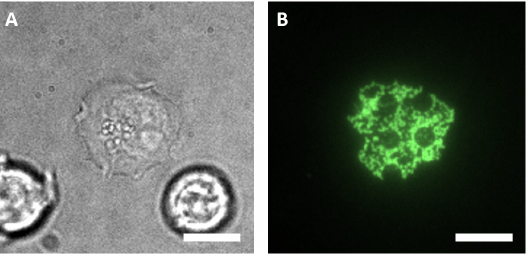
Figure4. Testingforspecificprotein–receptorinteraction. Epidermalgrowthfactor(EGF)isimmobilized Figure 4. Testing for specific protein–receptor interaction. Epidermal growth factor (EGF) is onto the whole surface except on the PEGylated dot areas. Bright-field image ( A ) and representative immobilized onto the whole surface except on the PEGylated dot areas. Bright‐field image ( A ) and TIRF image ( B ) of a Jurkat cell expressing EGFR-GFP on the EGF micropatterned COP surface. Scale representative TIRF image ( B ) of a Jurkat cell expressing EGFR‐GFP on the EGF micropatterned COP bar: 10 µ surface. Scale bar: 10 μm.